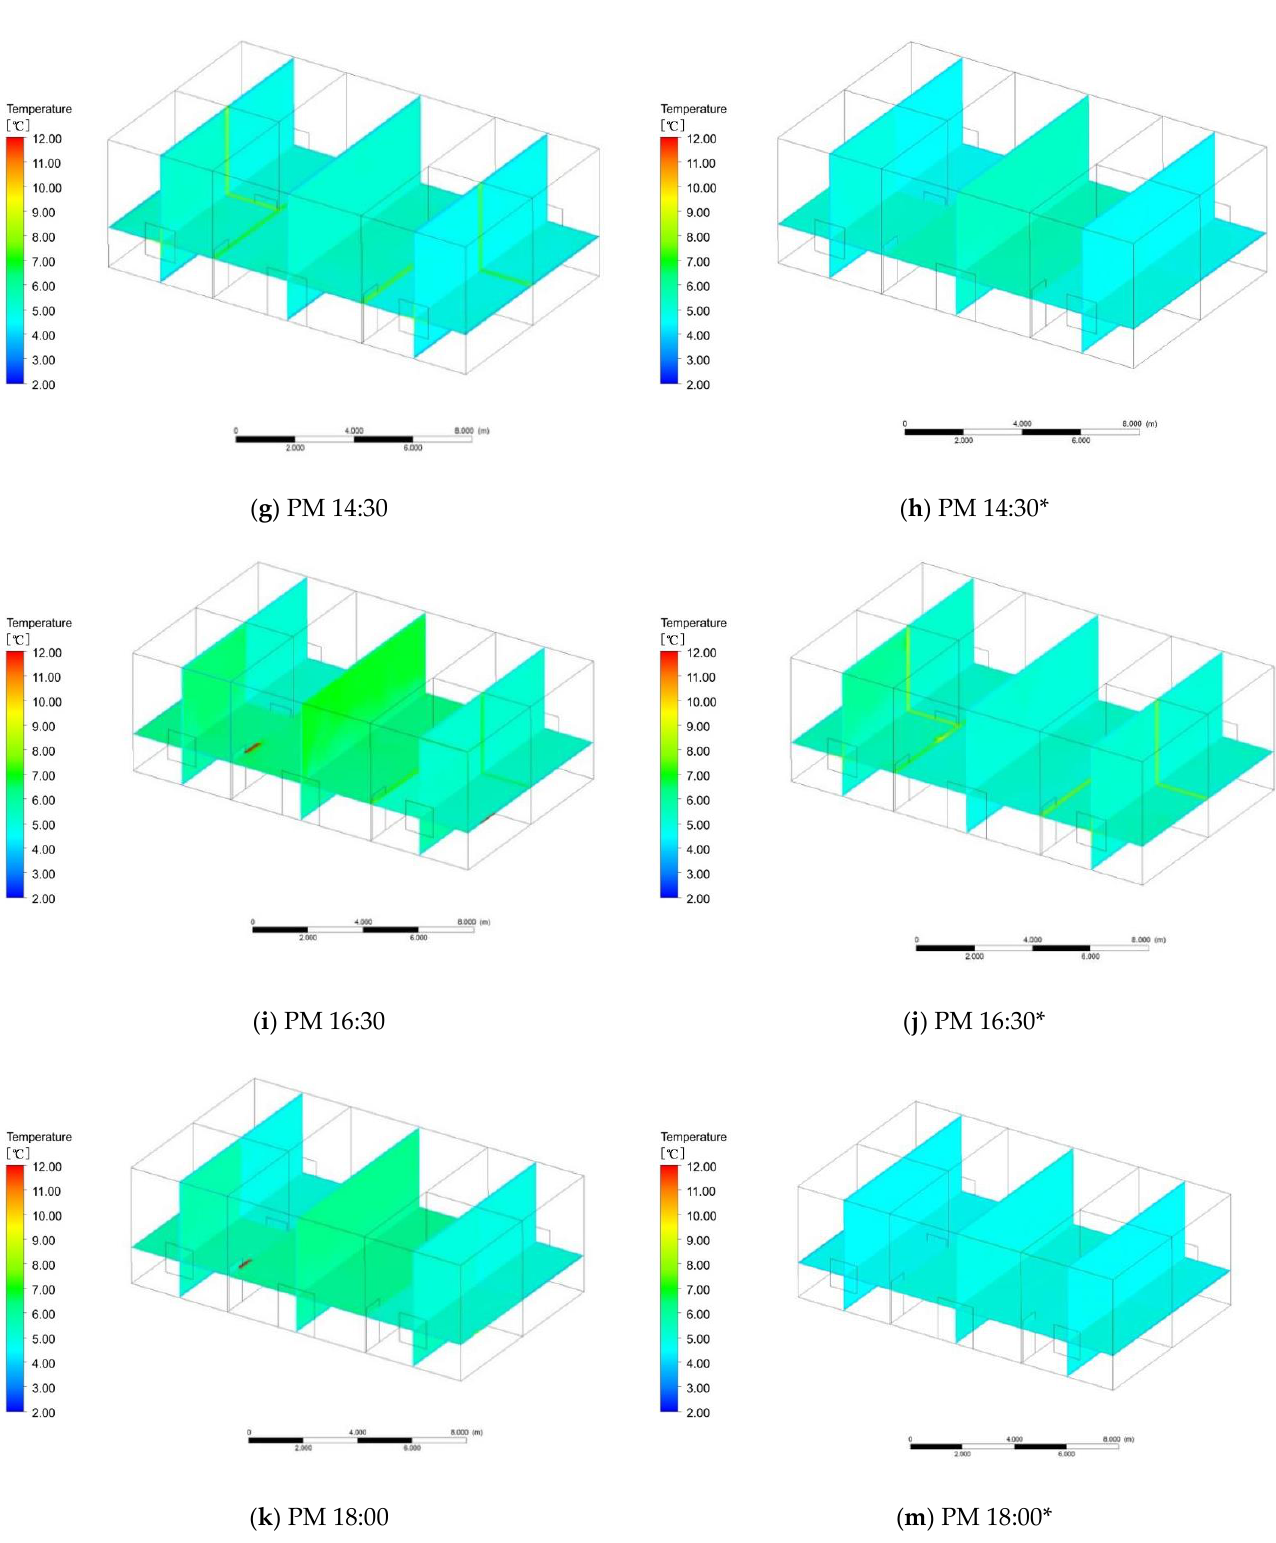
Figure 8. Natural heating at defined times; * refers to heating without solar radiation. Through software simulation calculation, the indoor temperature is basically the same as the outdoor temperature in the case of natural heating without solar radiation. The simulated time is the same as the natural heating with solar radiation, and the time is also from 9:00 to 18:00. From 9:00 to 12:00, the average temperature of the first and second